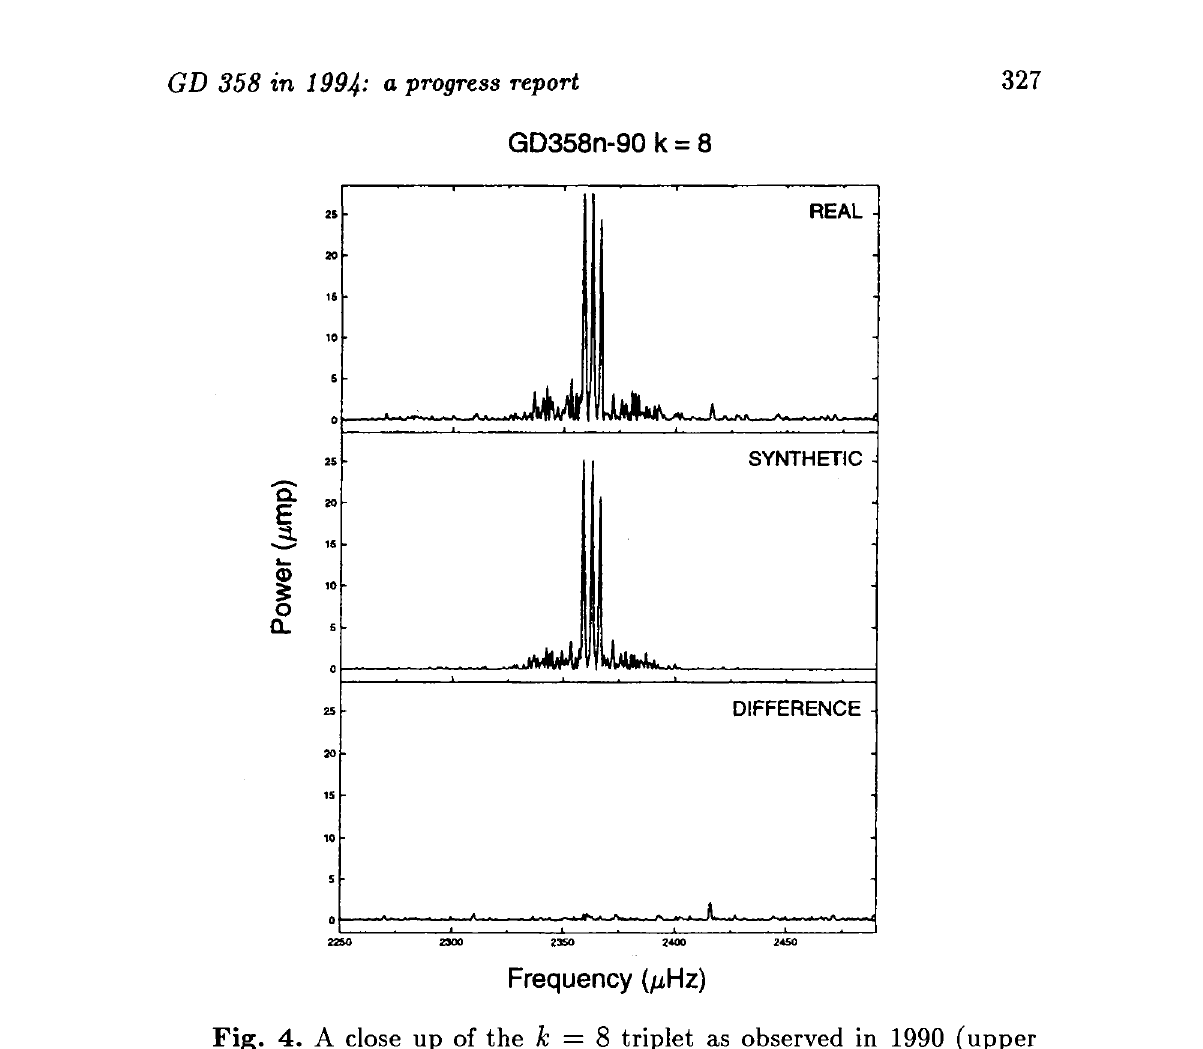
Fig. 4. A close up of the k = 8 triplet as observed in 1990 (upper panel), and a Fourier transform of a synthetic light curve including only the frequencies, amplitudes and phases for the triplet members. The bottom panel shows the FT of the residual light curve when the synthetic light curve is subtracted from the observed